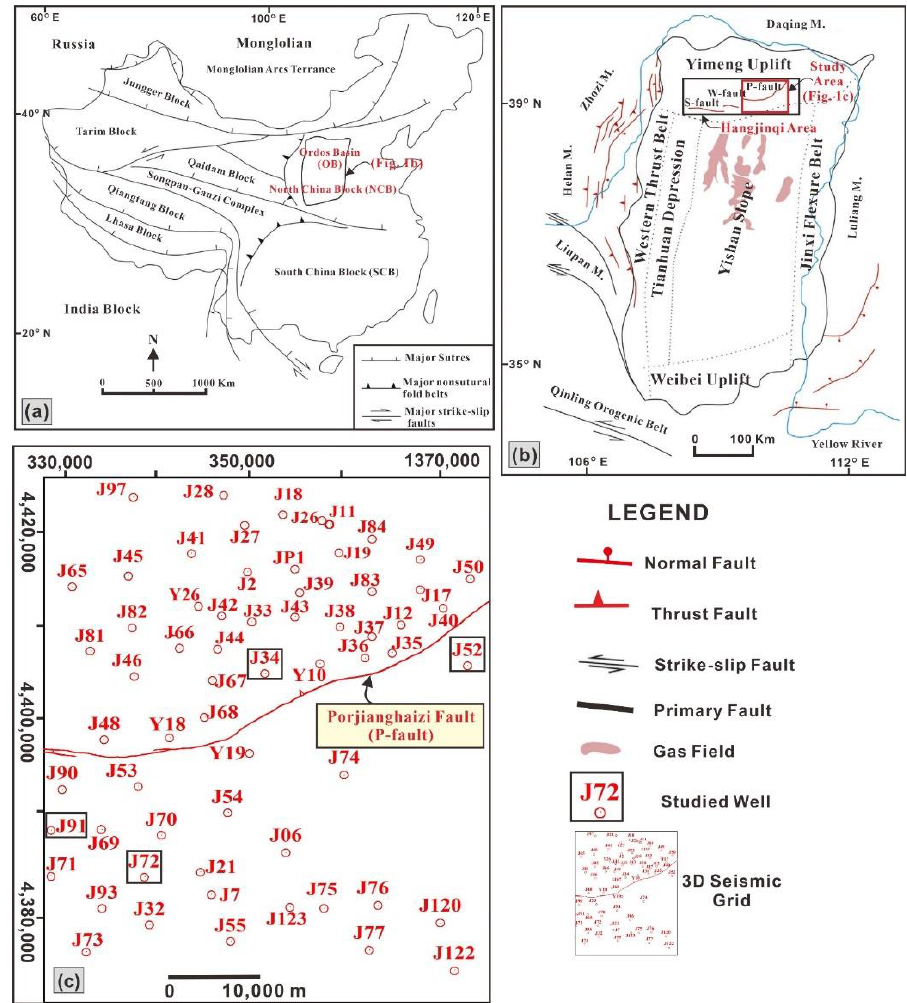
Figure 1. ( a ) Tectonic map of China (modified after [9]), ( b ) Major tectonic units of OB (modified after [9]), ( c ) 3D seismic grid and wells incorporated in our